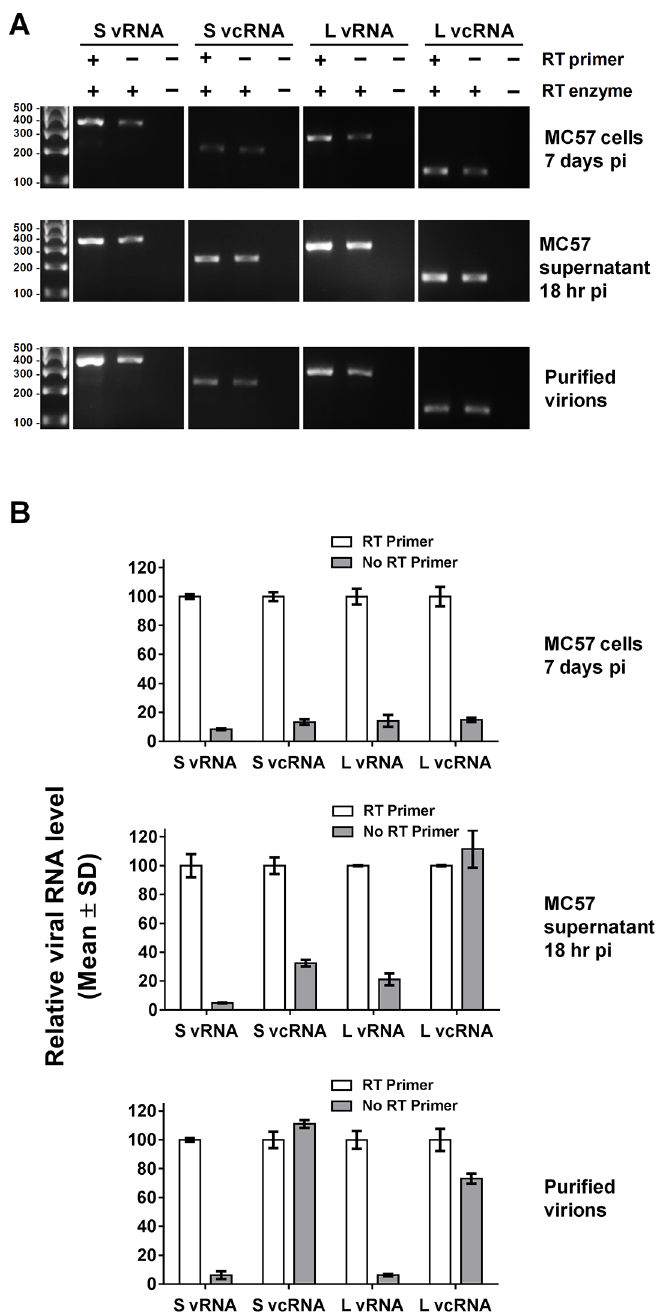
Fig 3. Nonspecific conversion of arenavirus RNA species into cDNA during RT. (A) RNA was extracted from i) MC57 cells 7 d after infection with LCMV, ii) cell-free supernatant collected from MC57 cells 18 hr pi with LCMV, or iii) sucrose-banded LCMV particles collected from Vero E6 cells at 48 hr pi. Each sample was subjected to standard RT-PCR targeting the vRNAs or vcRNAs of the L or S segment, as indicated, using the primers described in Tables 1 and 2. In each case, the RT was performed with: i) the RT enzyme and an RT primer, ii) the RT enzyme but no RT primer, or iii) no RT enzyme and no RT primer. It should be noted that the data shown in panel (A) were obtained during the linear and/or plateau phase of the PCR reaction. Therefore, these data are not suitable for exact quantitation, but rather reflect the presence or absence of a particular cDNA. (B). RNA extracted from the samples listed in panel (A) of this figure were subjected to QRT-PCR targeting the vRNAs or vcRNAs of the L or S segment, as indicated, using the primers and probes described in Tables 1 and 3. Similar to panel (A), in each case, the RT was performed with: i) the RT enzyme and an